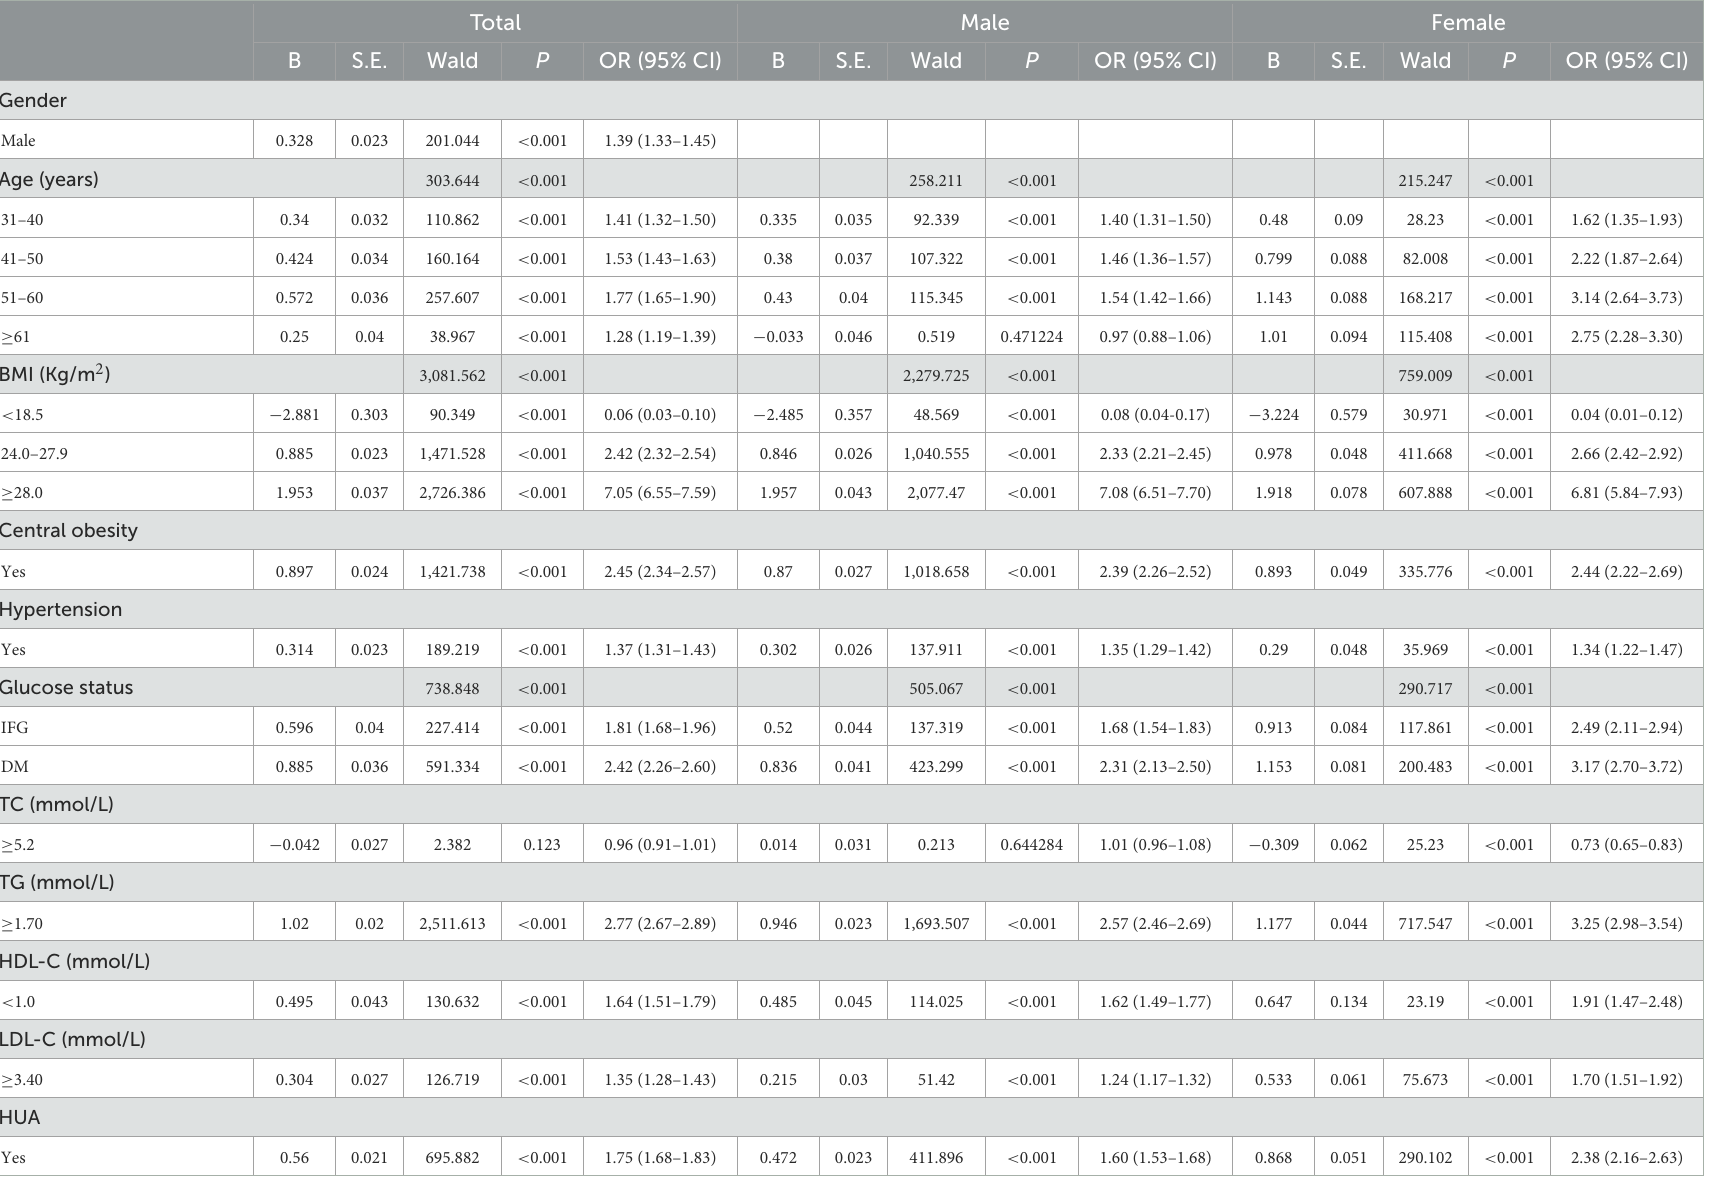
TABLE 3 Association between risk factors and NAFLD analyzed by univariable binary logistic regression ( N =